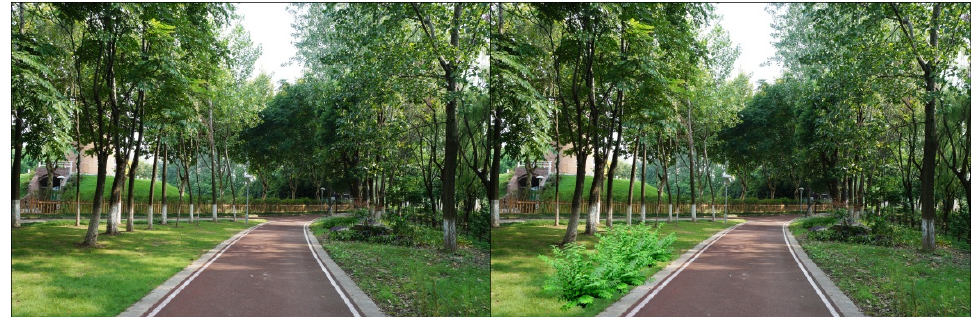
Figure 13. Diverse mix of plants (“barrier” height plants were added).